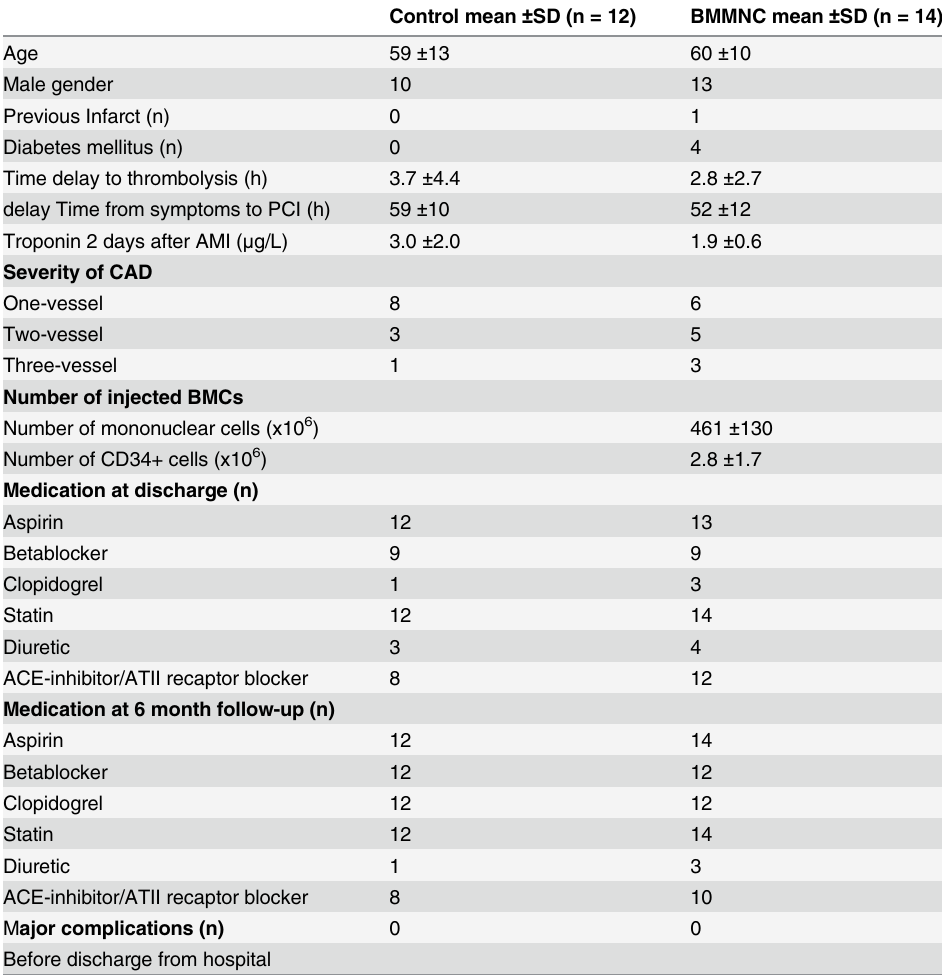
Table 2. Characteristics of